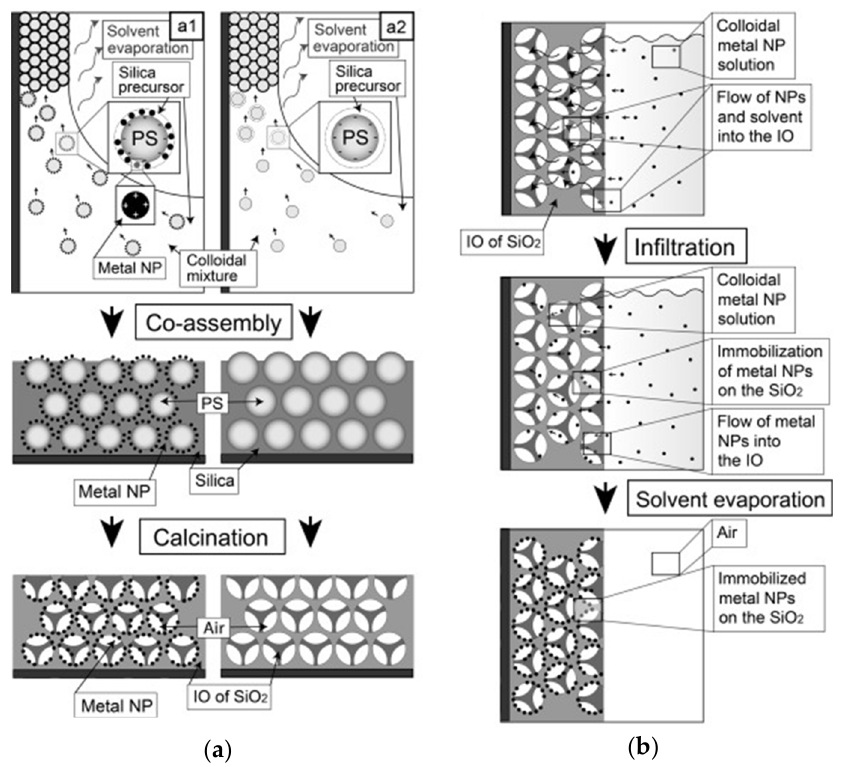
Figure 4. Fabrication of SiO 2 photonic crystal (PC) films using: ( a ) co-assembly method in which PCs were prepared with (a1) and without (a2) positively charged metal NPs and ( b ) infiltration method; Reprinted with permission (after formatting) from [111]. Copyright (2015) Elsevier.